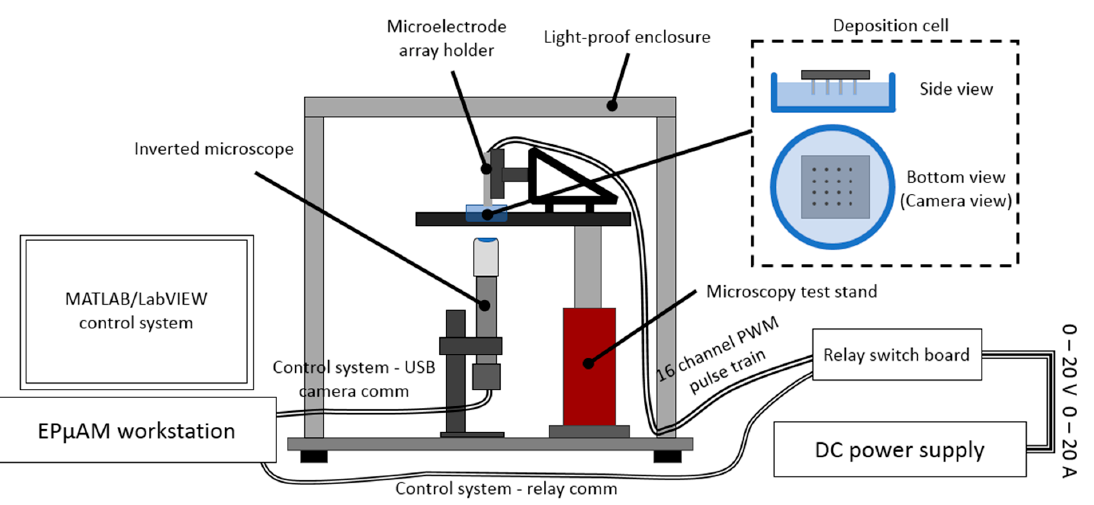
Figure 2. Schematic of the EP µ AM experimental setup. The particle deposition cell is located within a lightproof enclosure above the inverted microscopy setup. The PC workstation is used to control the relay switchboard and to capture digital images from the microscope.